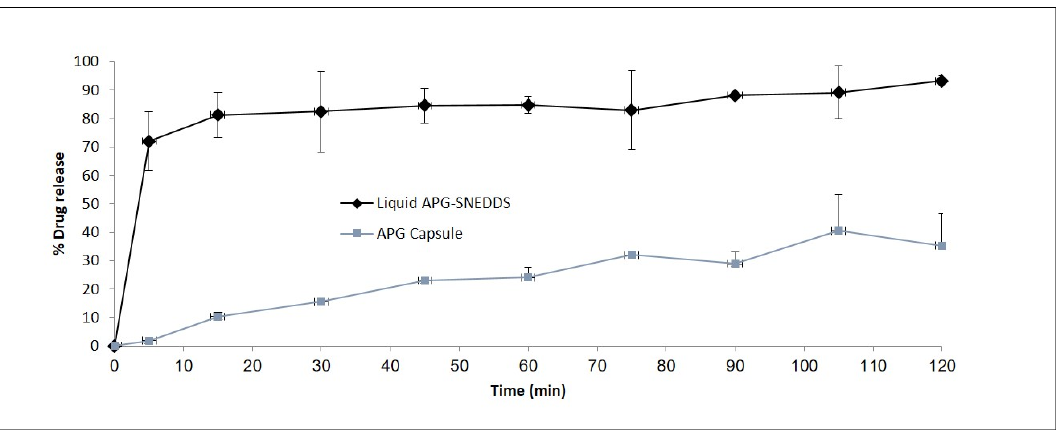
Figure 8. In vitro dissolution profiles of the representative APG-loaded liquid F11-Bio-SNEDDS (CoFA:CMCM:TC (3:1:1)/HCO30 [1/1]) the and commercial APG capsule in aqueous media (pH 6.8) over 120 min. Data are presented as mean ± SD, ( n = 3).